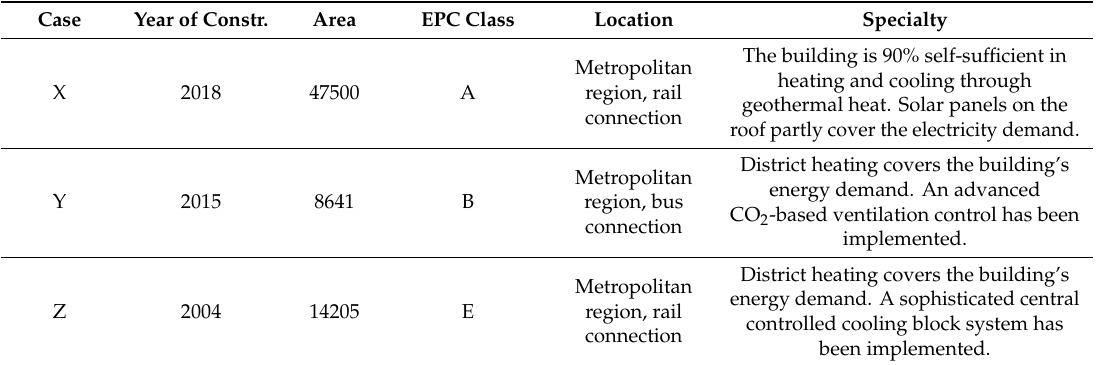
Table 2. Key characteristics of the case